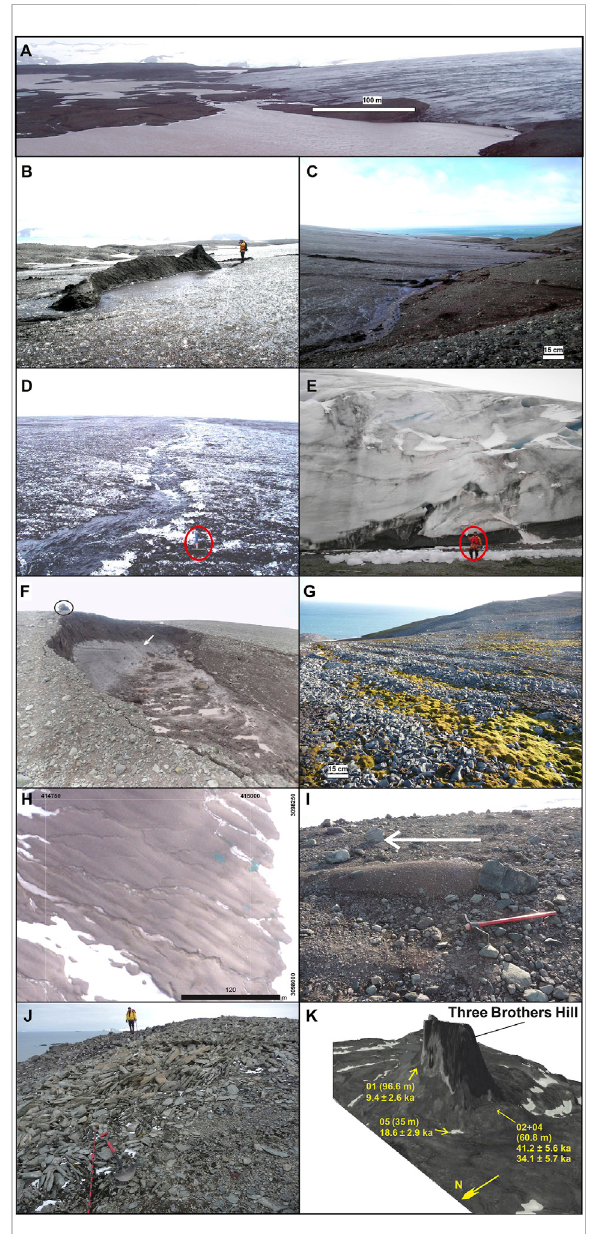
FIGURE 4 Examples of the active glacial landform assemblages of the Warszawa Ice fi eld on Potter Peninsula: (A) Transverse structures and radial longitudinal foliation. (B,C) Transverse foliation related to englacial thrusts and longitudinal foliation associated with melt-out till on the ice surface on the Warszawa Ice fi eld foreland. (D) A supraglacial meltwater channel. (E) Folded layers of subglacial debris in the snout of the ice fi eld, toward the Fourcade Glacier. Components of the glacial and periglacial landform assemblages observed on Potter Peninsula. (F) Slump on glacial deposits showing the collapsing ice-cored moraine (white arrow) at the Warszawa Ice fi eld foreland; bag on top as scale. (G) Vegetated large stone stripes above Stranger Point. (H) Satellite image showing fl utings in recently deglaciated glacial deposits, being eroded by glacio fl uvial activity. (I) Flutes at a smaller scale, indicating former ice movement direction. (J)